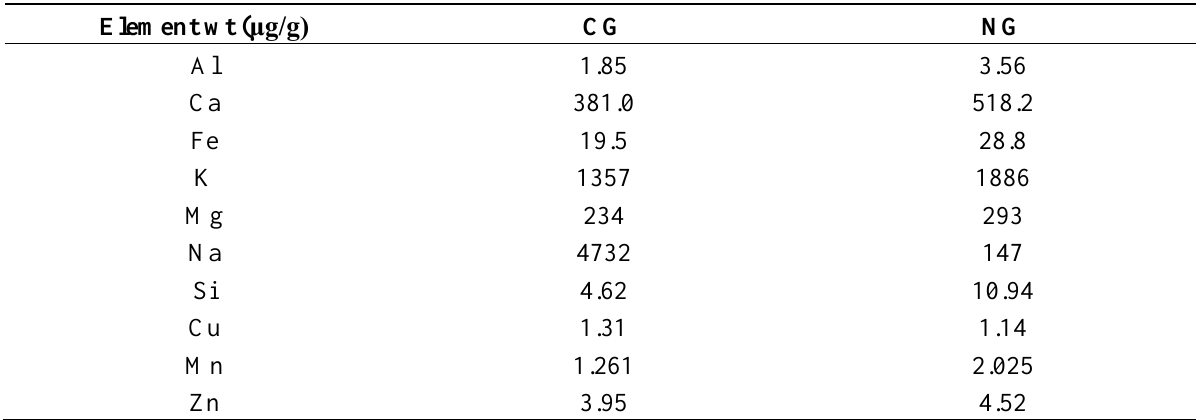
Table 2. Elemental Content Measured in neutral guar gum (NG) and Cationic guar gum